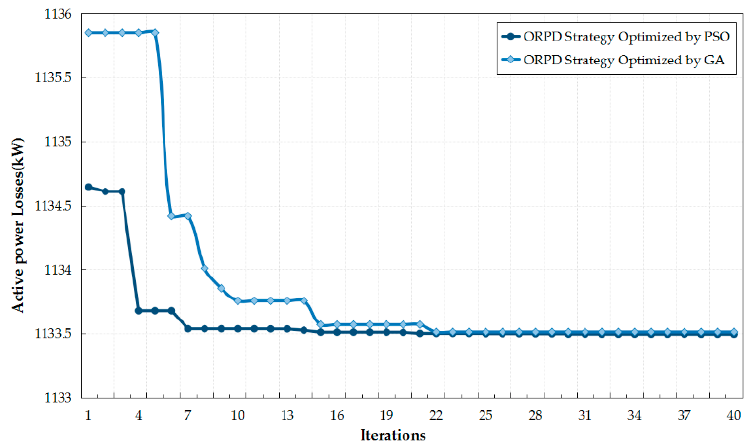
Figure 13. Changes in the active power loss versus the number of iterations for the different algorithms.